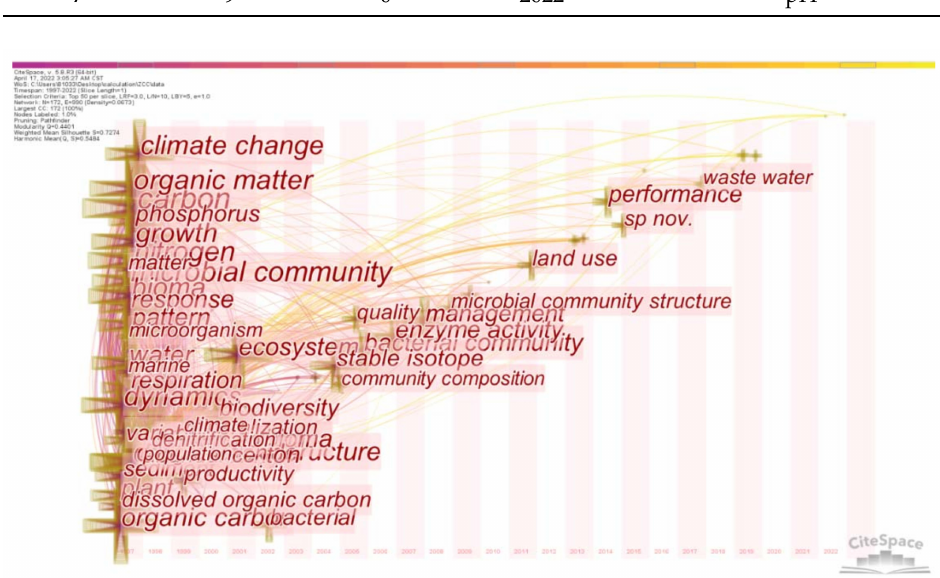
Figure 9. Annual variations of co-occurring keywords of the papers on ZCC during